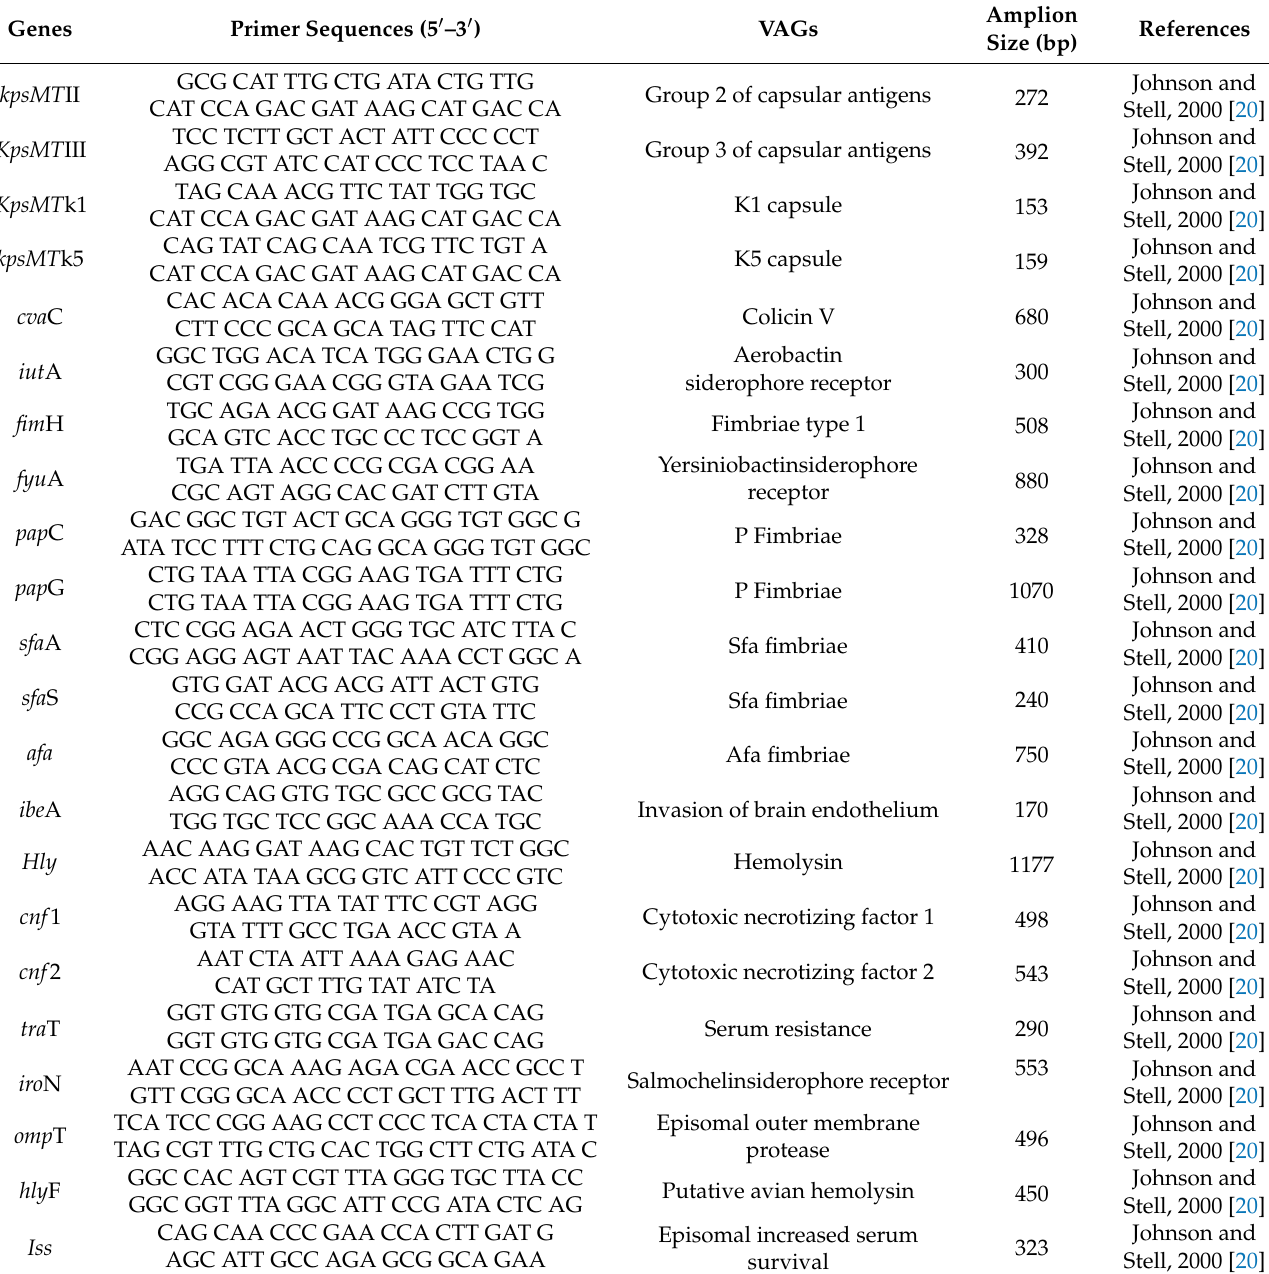
Table 2. Virulence-associated